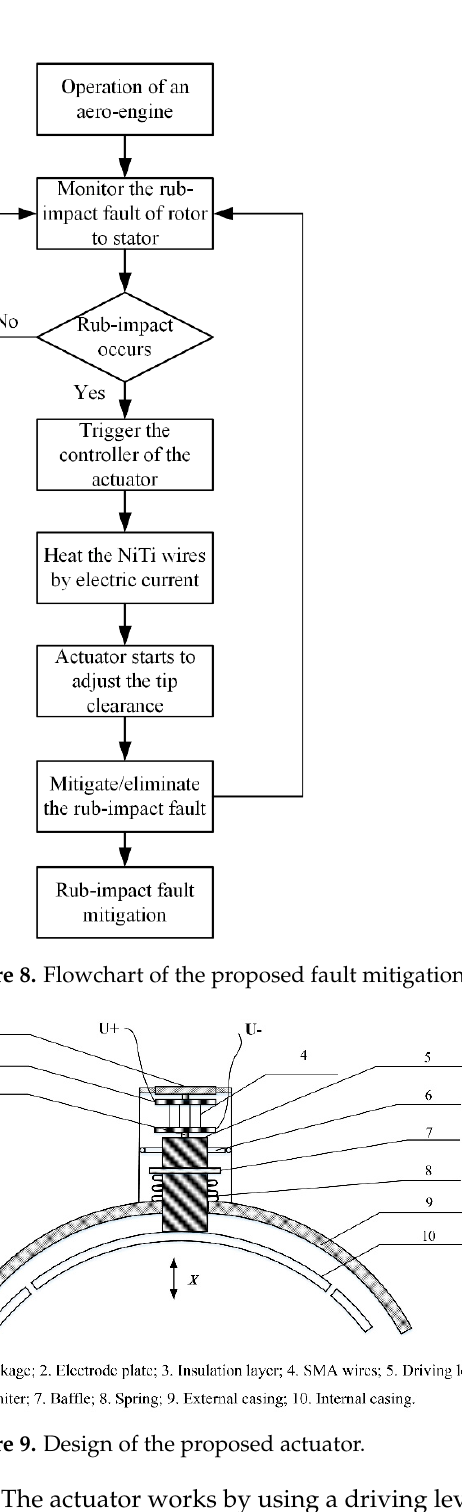
Figure 9. Design of the proposed actuator.